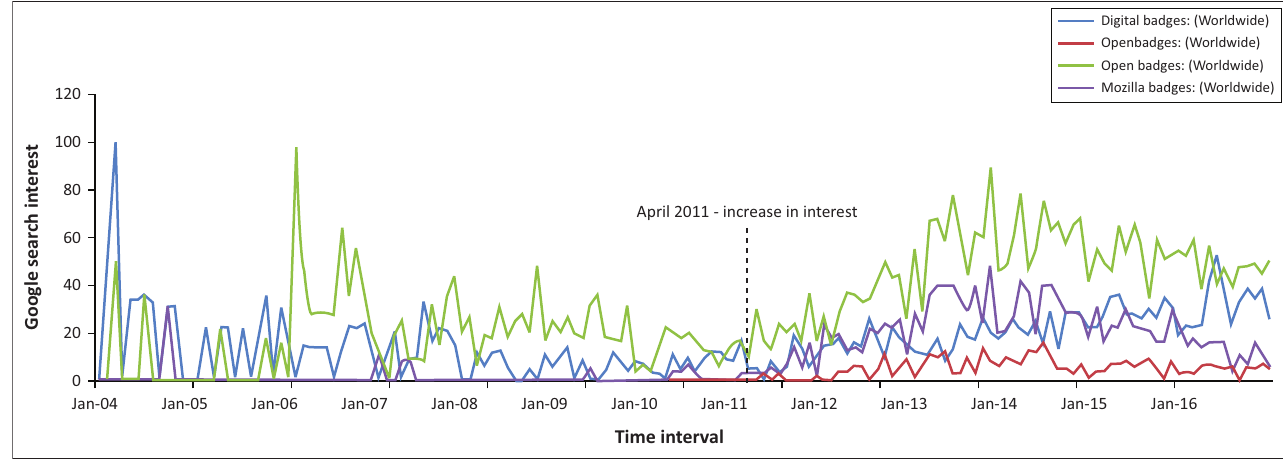
FIGURE 1: Google Trends search results for